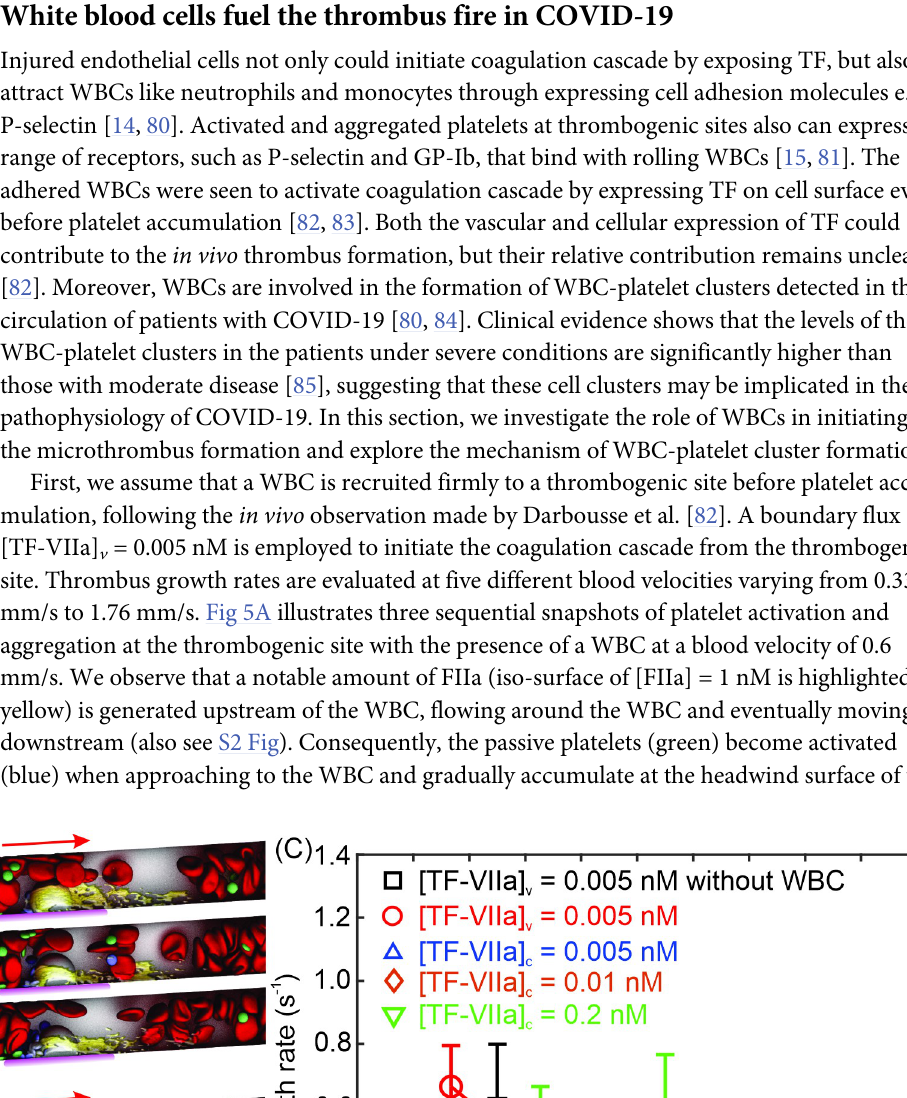
= 0.005 nM and (B) v = 0.005 v